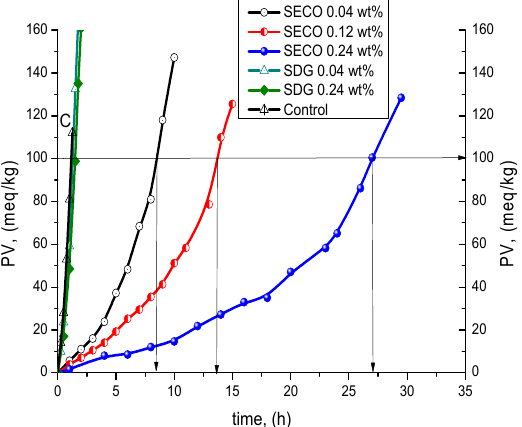
Figure 6. Kinetic curves of LOOH accumulation of TGSO autoxidation process till PV = 100 meq/kg at 80 °C in absence (C, control) and in presence of SECO and SDG.